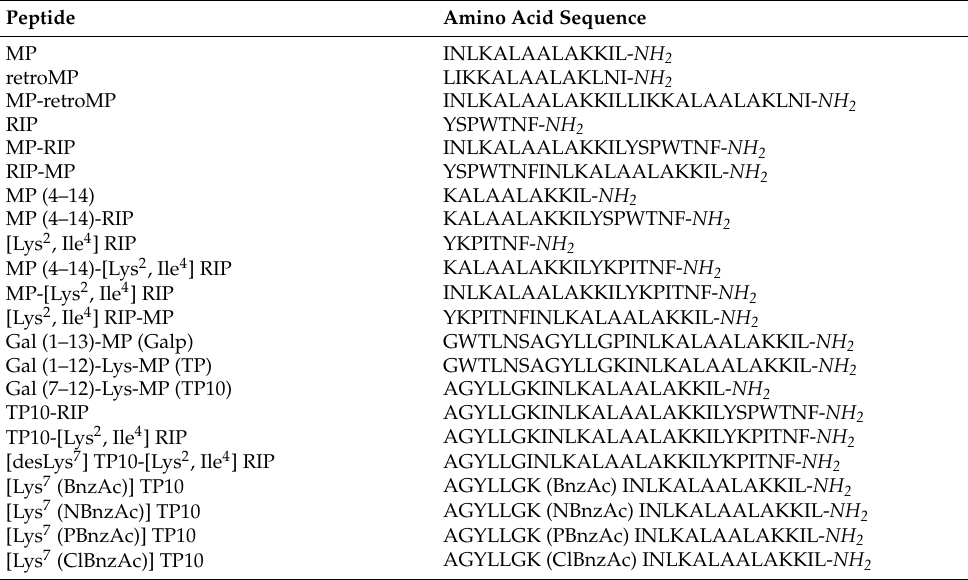
Table 1. Primary structures of synthesized